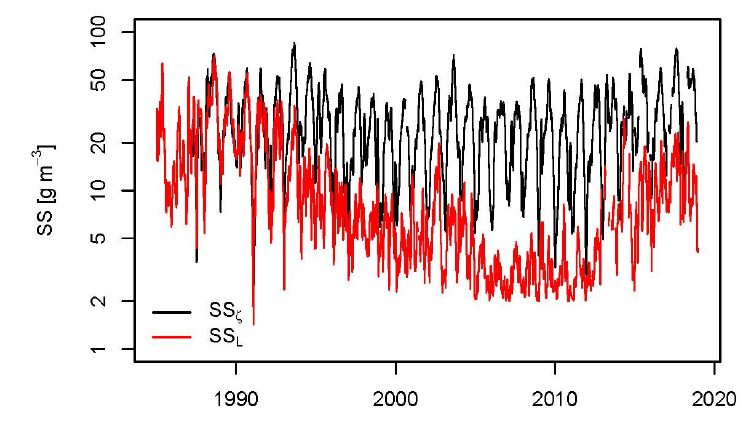
Figure 7. Observed SS concentrations at sites ζ and L (1 month moving averages). The Ingói reeds operated between the two dashed lines.